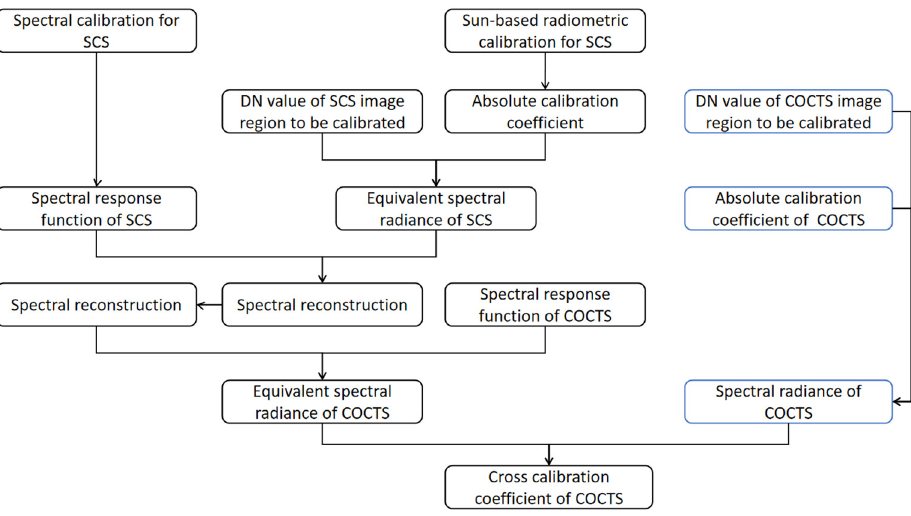
Figure 3. Standard cross-calibration process of COCTS and SCS.